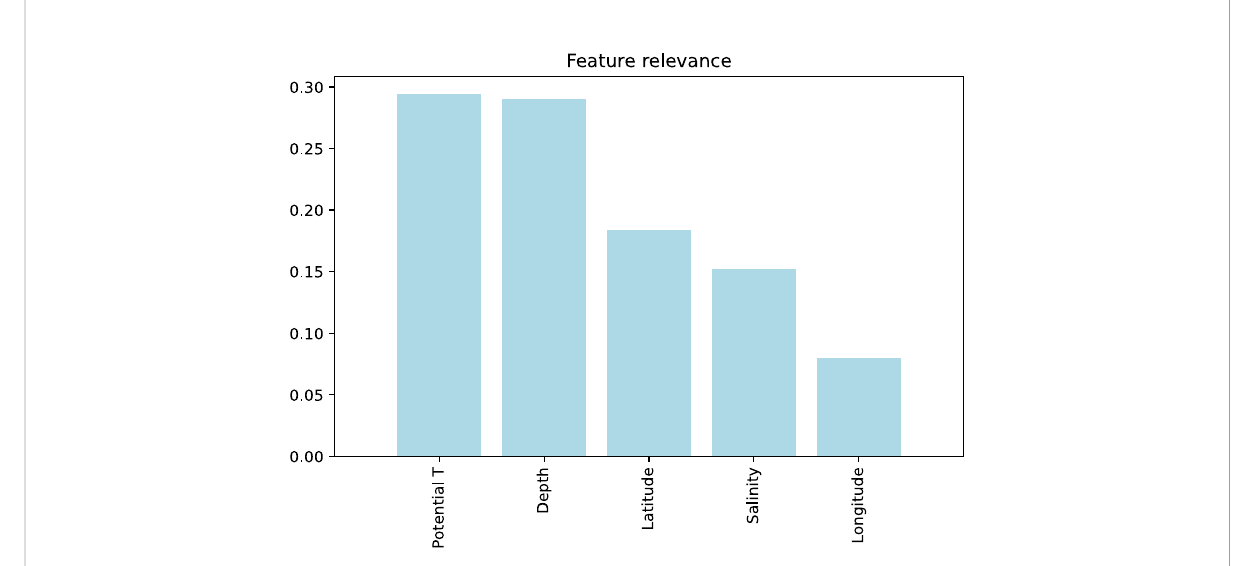
FIGURE 4 Feature relevance for the Extremely Randomized Trees regression model with the additional water mass